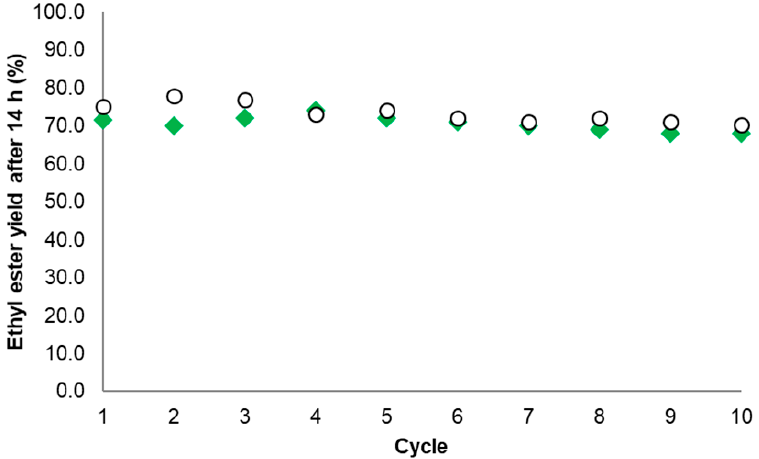
Figure 8. Ethyl ester yield (% w / w ) after successive reaction cycles. Commercial reference Novozyme ® 435 ( ○ ) and the novel biocatalyst based on aminated TLL immobilized on Gx at pH 7.0 with 20 mM AA ( ) . Conditions according to Sections 3.5 and 3.6.